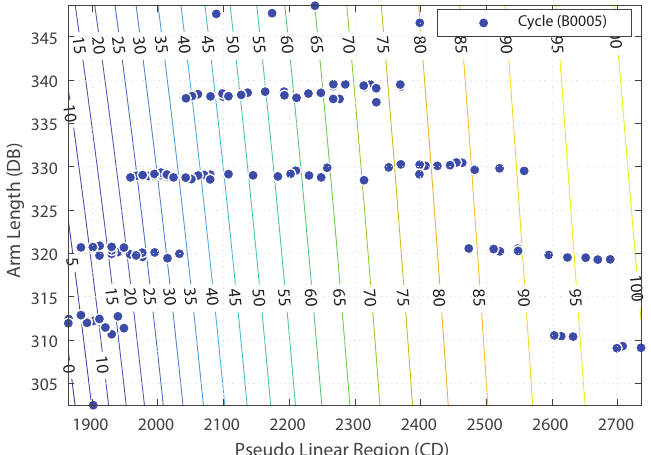
Figure 6. Contour plot showing the effect of cycle number on Arm Length and Pseudo Linear Region at 297.15